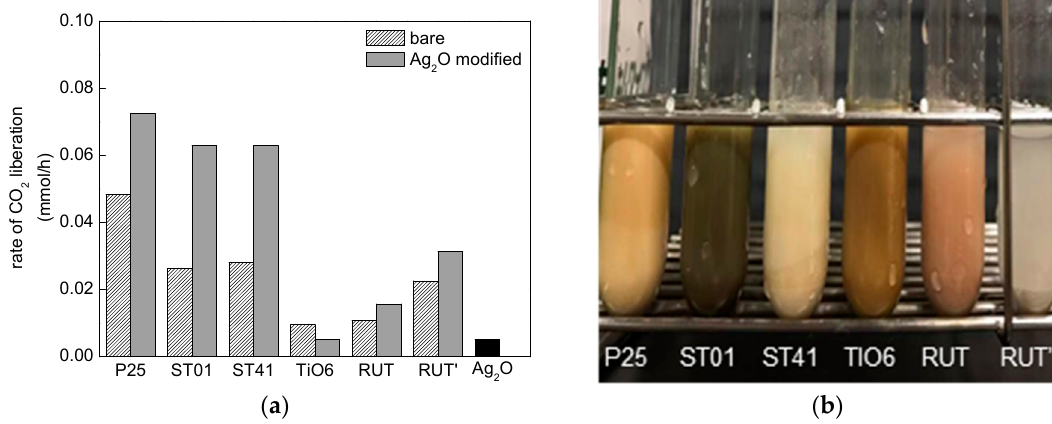
Figure 7. UV/vis photocatalytic efficiency of Ag 2 O/TiO 2 samples with a different titania matrix in acetic acid oxidation ( a ) with respective photographs of samples after 45-min irradiation ( b ).